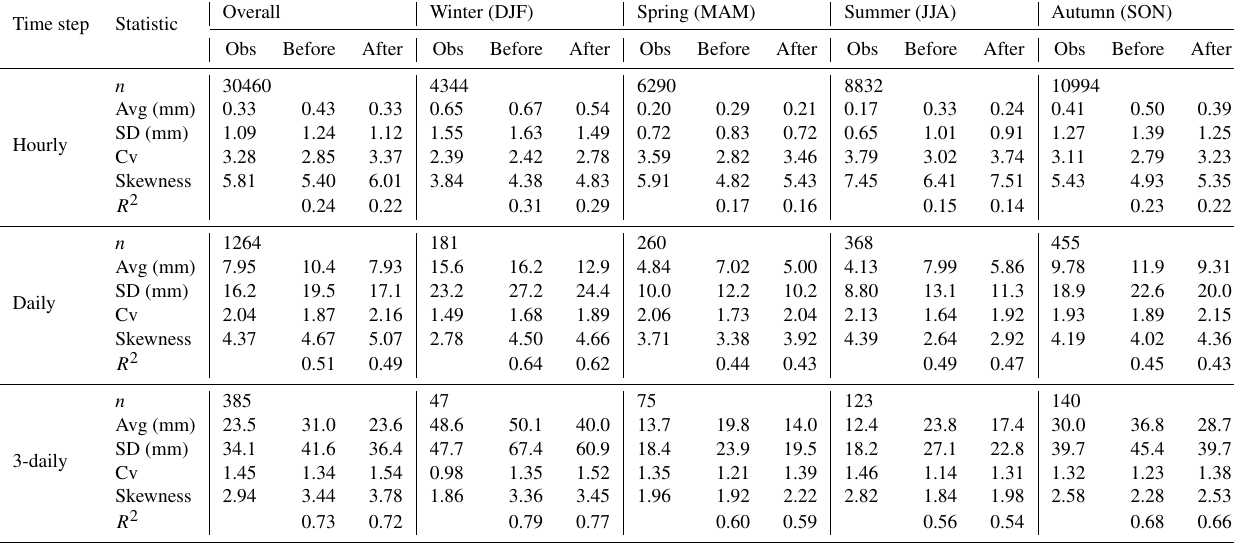
Table 1. Statistics calculated from the observed (Obs) precipitation data at AWS1 and from the corresponding ICRA precipitation data before and after bias correction. Statistics have been calculated at an hourly, daily and 3-daily time step and include n (total number of above-freezing measurements available at AWS1), avg (mean), SD (standard deviation), Cv (coefficient of variation), skewness and R 2 (coefficient of